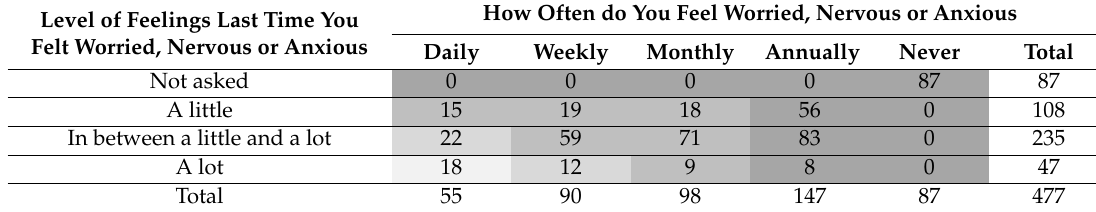
Color coding: Numbers in the rows / columns with the same color form the indicator levels